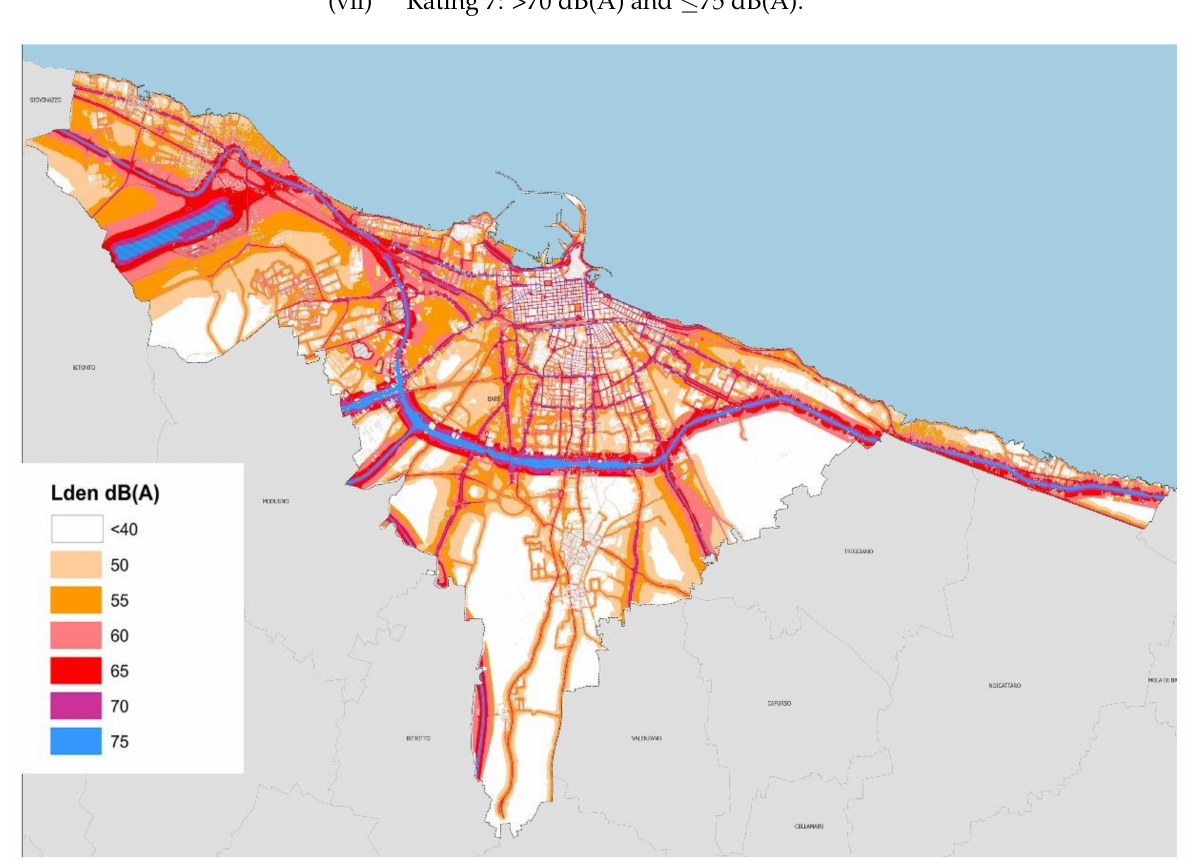
Figure 6. Strategic Noise Map of the city of Bari (Source: Arpa Puglia—Scientific Directorate, adapted from ref.